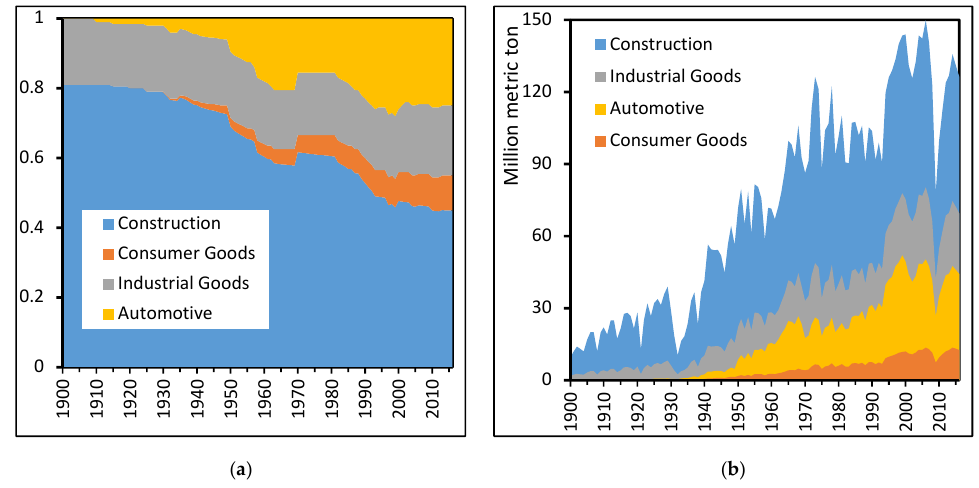
Figure 2. Input data on U.S. steel consumption by industry sector between 1900 and 2016: ( a ) ratios of relative steel consumption per industry sector and ( b ) tonnages of steel consumed.